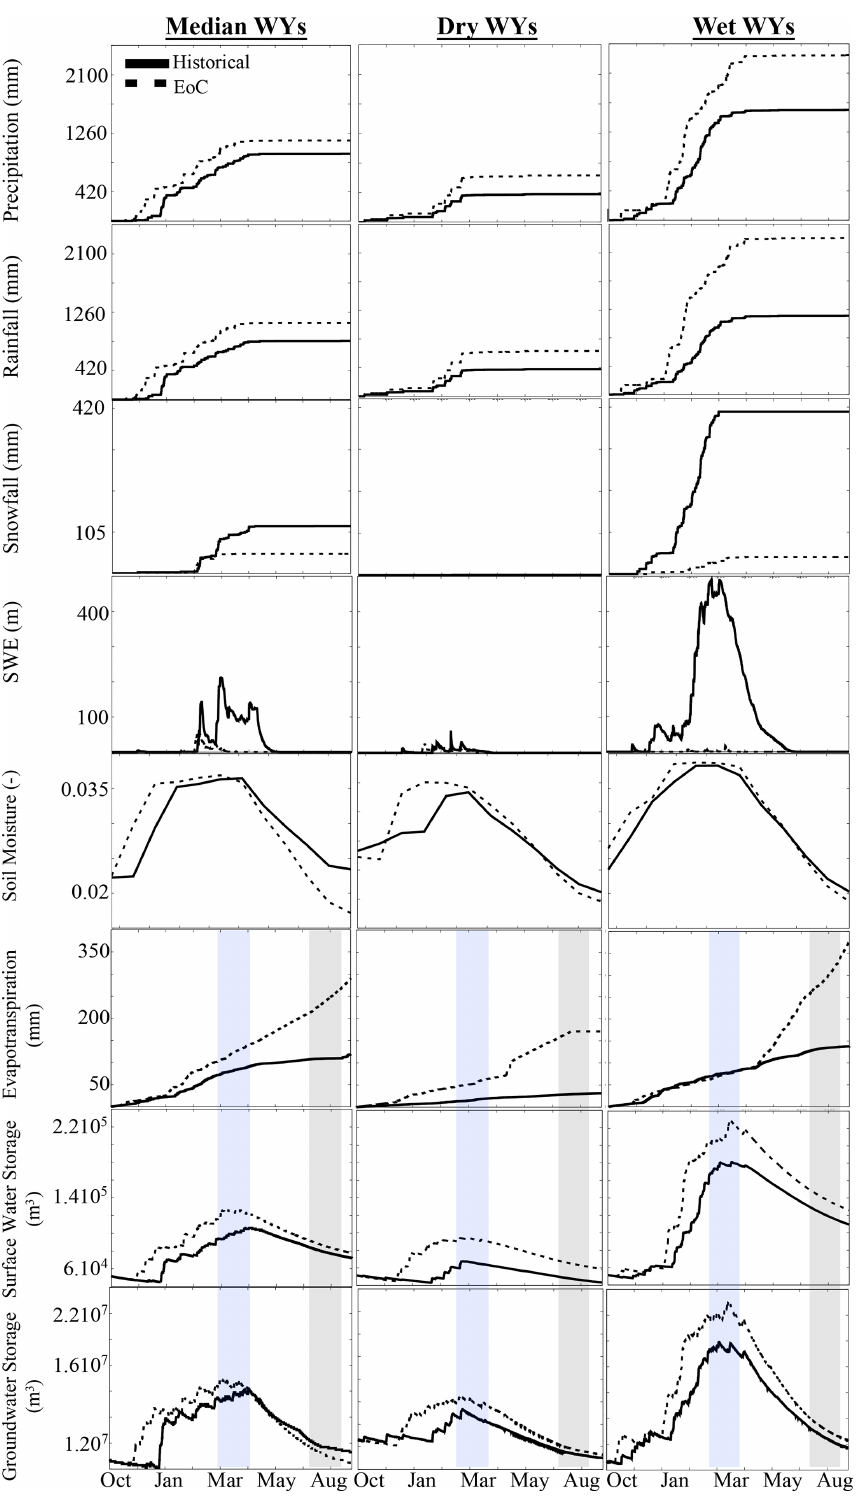
Figure 5. Temporal variations of the total cumulative precipitation, rainfall, and snowfall at the watershed scale, total SWE at the watershed scale, the average watershed values of soil moisture, the cumulative watershed ET, and the total surface water, and groundwater storages at the watershed scale associated with the 6 historical and EoC water years (WYs). The blue area indicates the selected peak flow period, while the gray area corresponds to the selected baseflow conditions for the spatial distribution